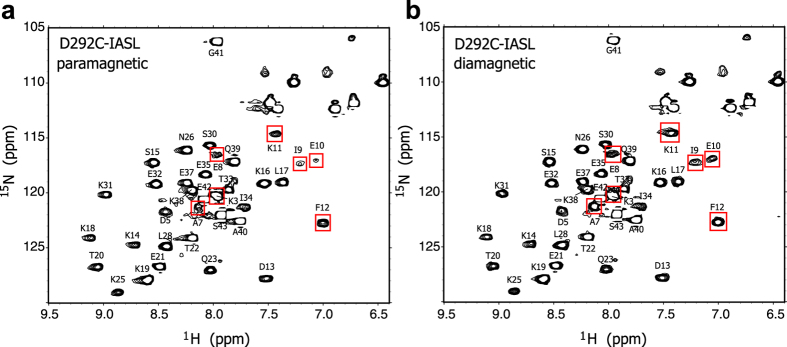
PRE experiments between Tβ4 and D292C-IASL actin.1H-15N HSQC spectra of Tβ4 in complex with D292C-IASL actin in the paramagnetic (a) and diamagnetic (b) states. Assignments of Tβ4 signals in the complex with G-actin were based on the previous report9. Amide resonances that showed significant intensity reductions (Ipara/Idia < 0.70) are indicated by red boxes.